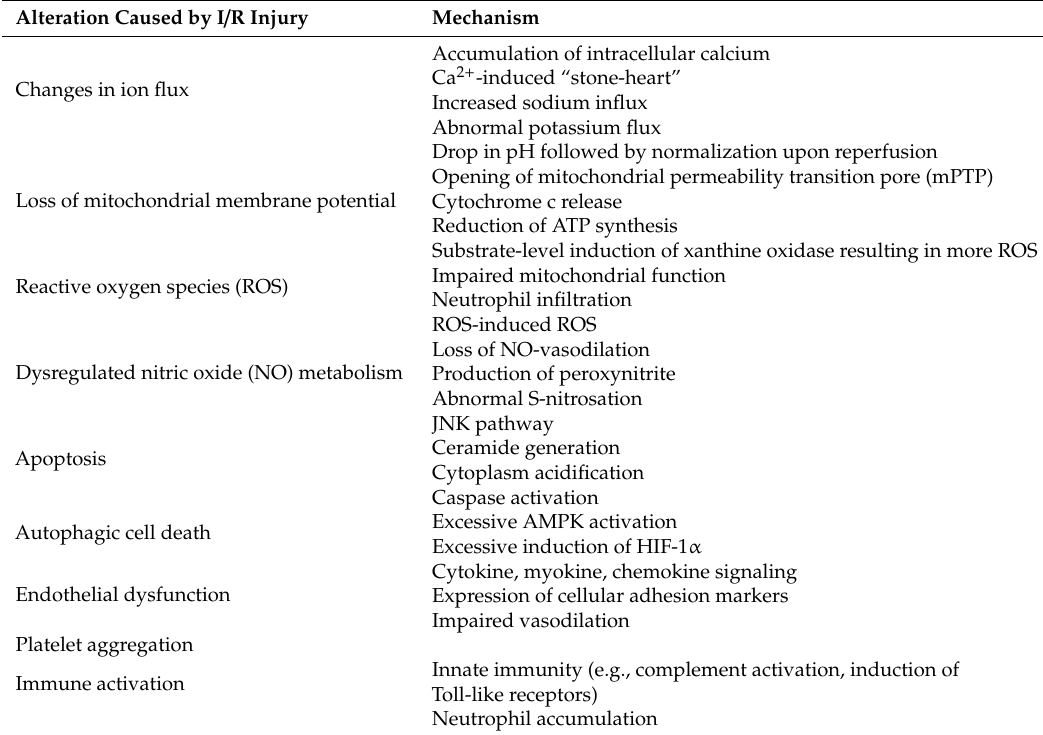
Table 1. Various mechanism underlying the pathophysiology of myocardial ischemia / reperfusion injury (modified according to reference [60]) JNK = c-Jun N-terminal kinase, AMPK = AMP-activated protein kinase, HIF-1 α = Hypoxia-inducible factor